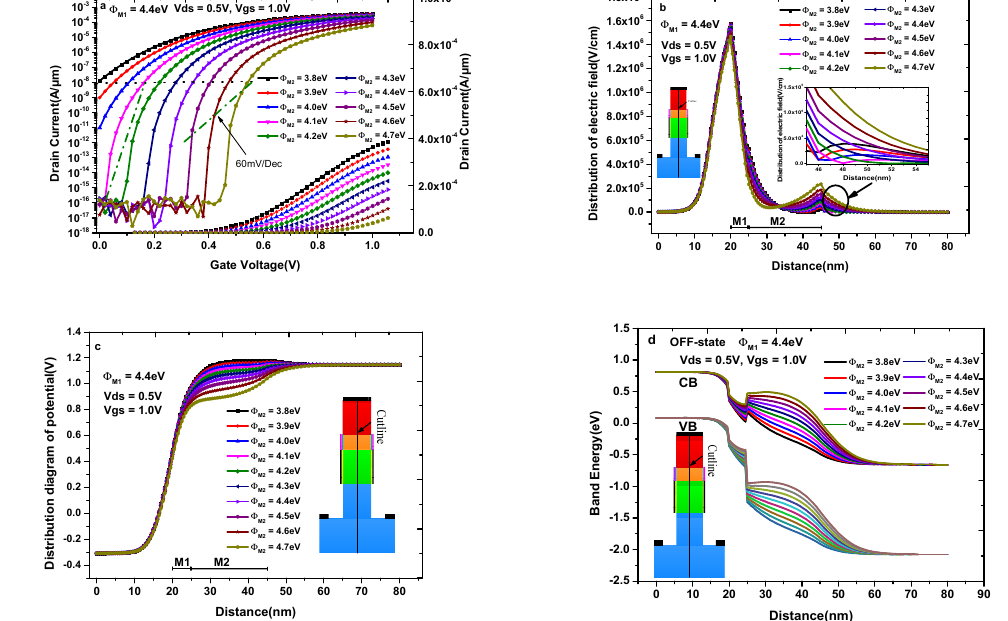
Figure 10. ( a ) Transfer characteristics of DMG-HD-VTFET with different Φ M2 ; ( b ) the distribution of electric field with different Φ M2 ; ( c ) the distribution of potential with different Φ M2 ; ( d ) the OFF-state energy band diagram with different Φ M2 .